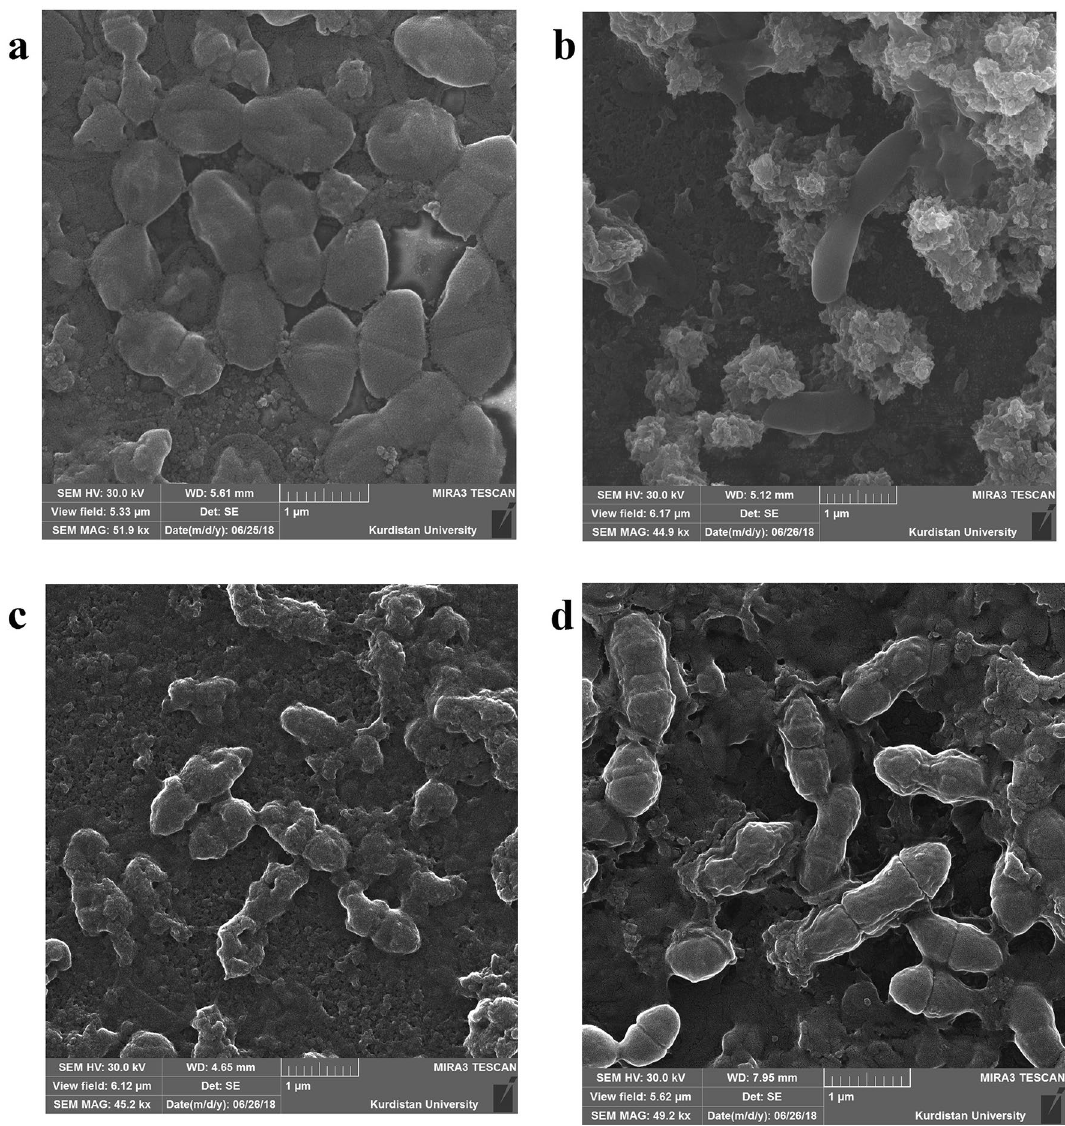
Figure 1. SEM images of E. faecalis mature biofilm treated with ( a ), Ca(OH) 2 ; ( b ), Ca 2+ ; ( c ), OH - for 7 days. The control group, d, was original biofilm without any treatment. The scale bar is 1